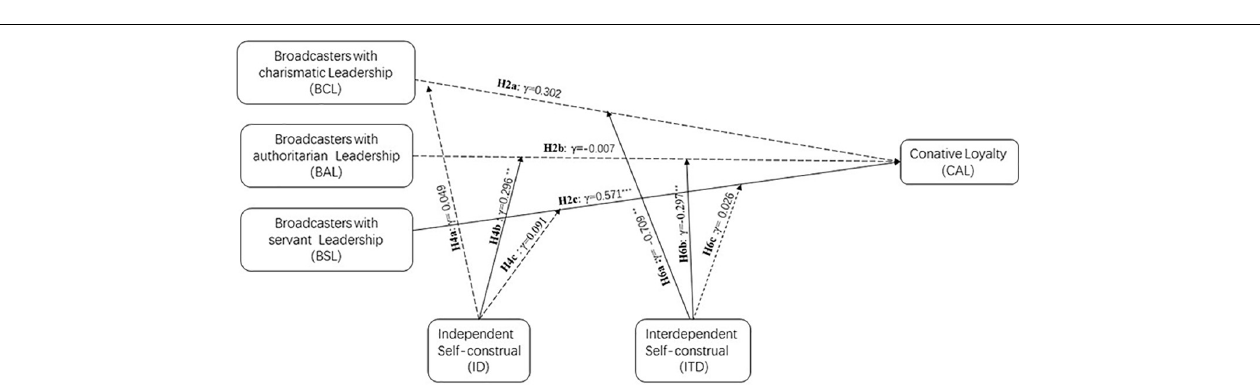
FIGURE 6 | Effect of broadcaster’s leadership and cognitive loyalty with self-construal as moderate.